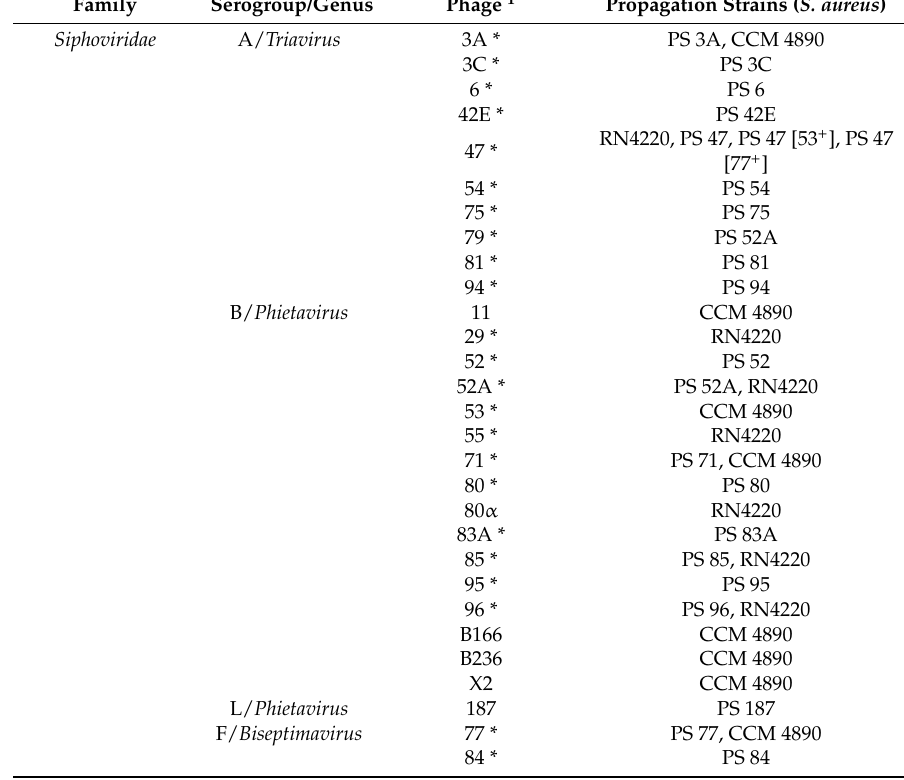
Table 1. List of bacteriophages and staphylococcal strains used in this work. Family